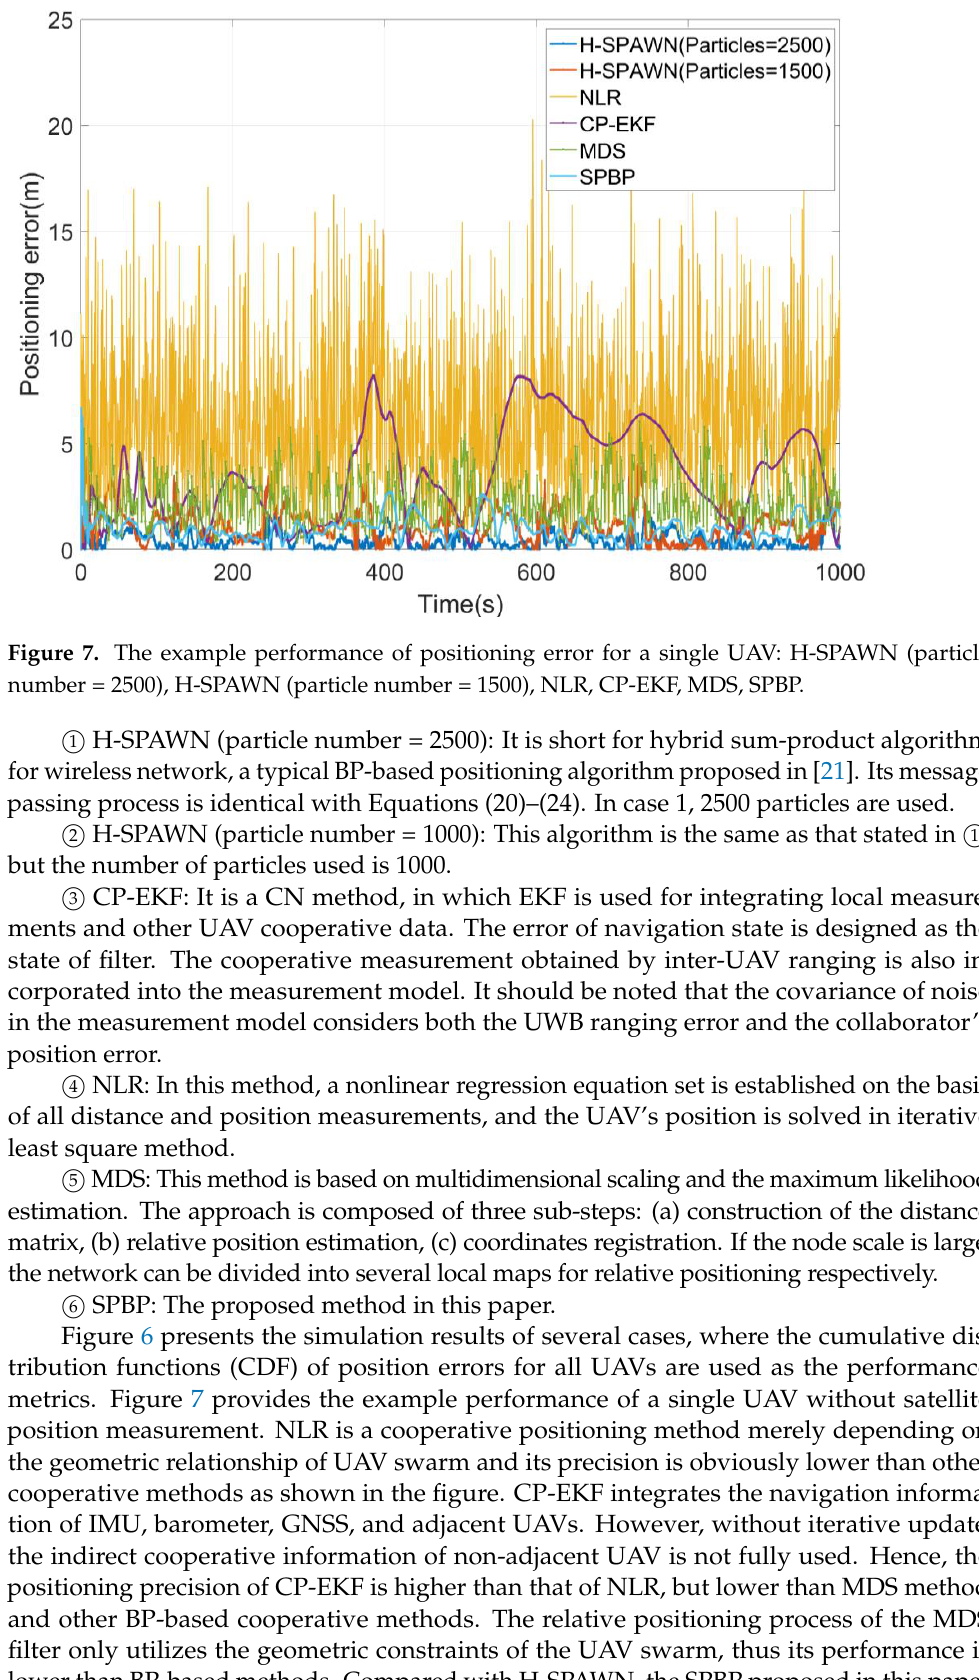
Figure 6. Positioning error CDF comparisons for all vehicles: H-SPAWN (particle number = 2500), H-SPAWN (particle number = 1500), NLR, CP-EKF, MDS, SPBP (positioning errors from 200 simu- lation trials).